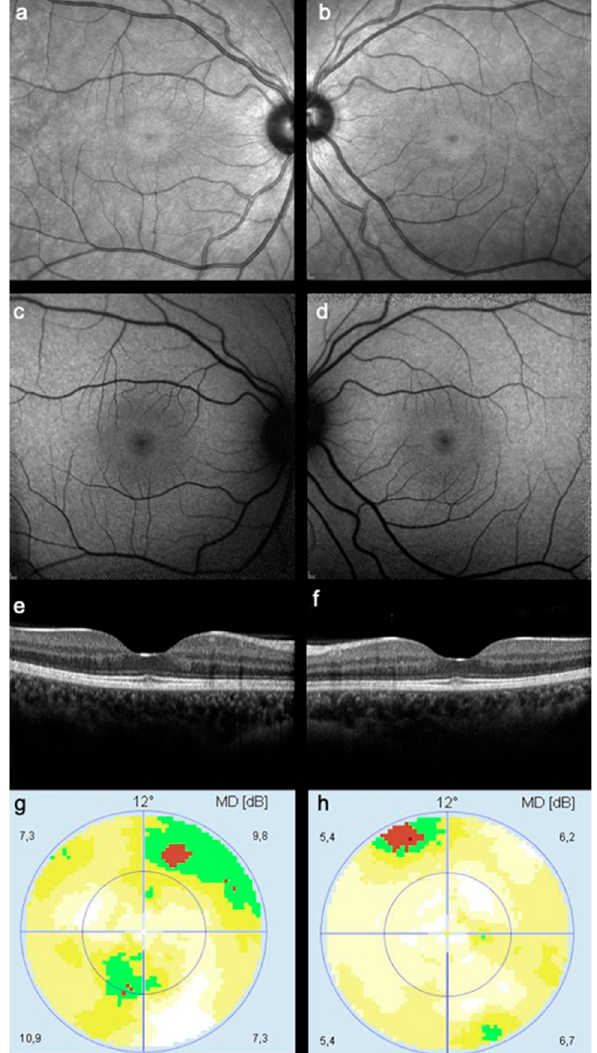
Figure 3. Case of a 23-year-old female with systemic lupus erythematosus using a weekly dose of 2800 mg of HCQ for 78 months. Note the presence of a hyperreflective ring in the NIR image suggestive of a bull’s eye lesion, in the ( a ) right and ( b ) left eye, respectively. The matching ( c , d ) FAF shows the paracentral hyperautofluorescence changes suggestive of a ring, but the ( e , f ) SD-OCT is unremarkable. The ( g , h ) 10-2 visual field testing was considered